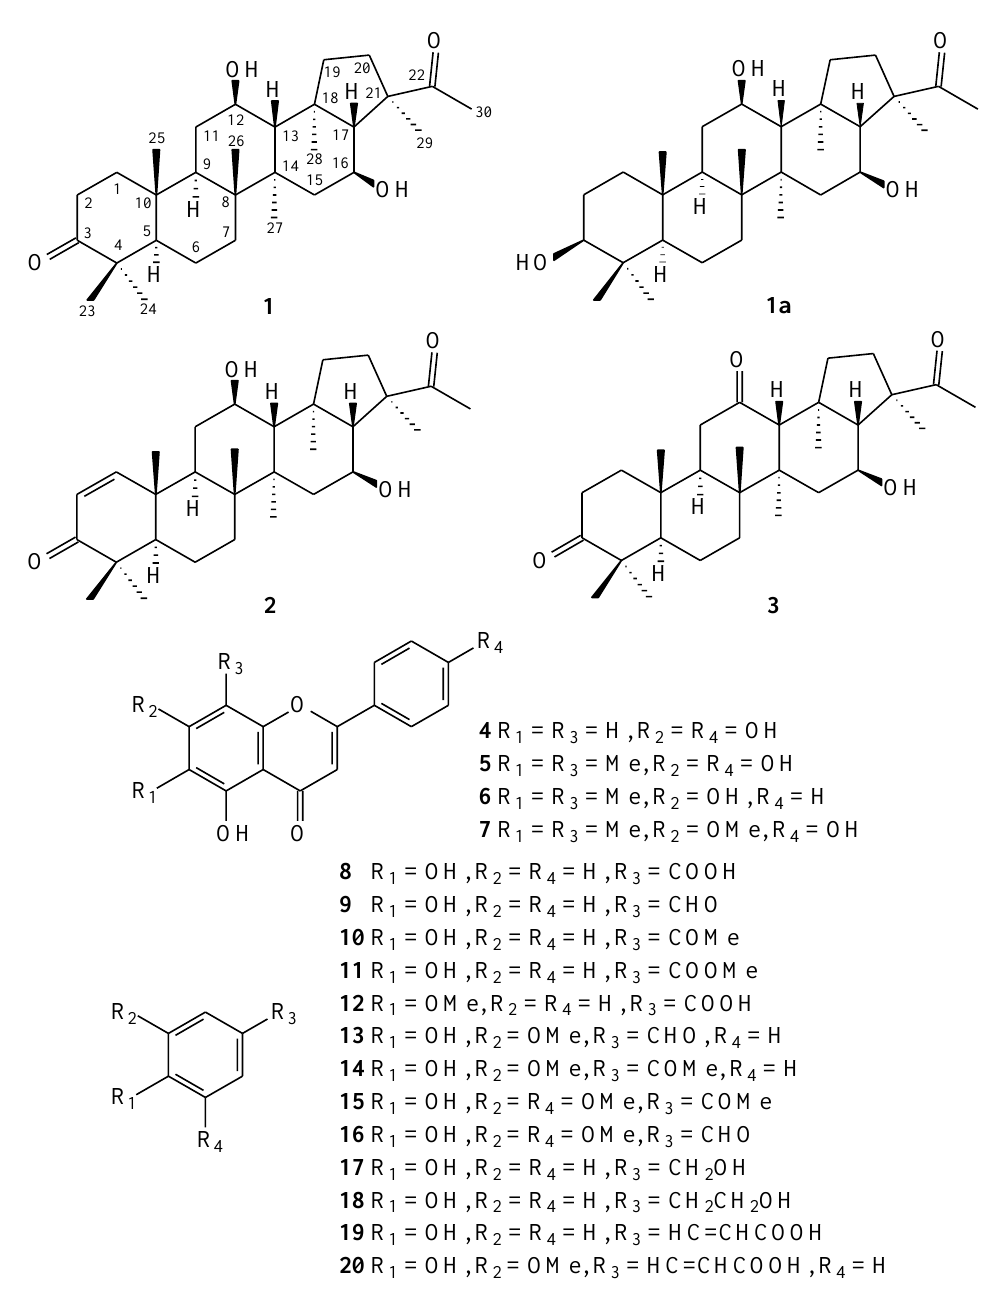
Spergulagenin B ( 1 ) was isolated as colorless needle with molecular formula C 30 H 48 O 4